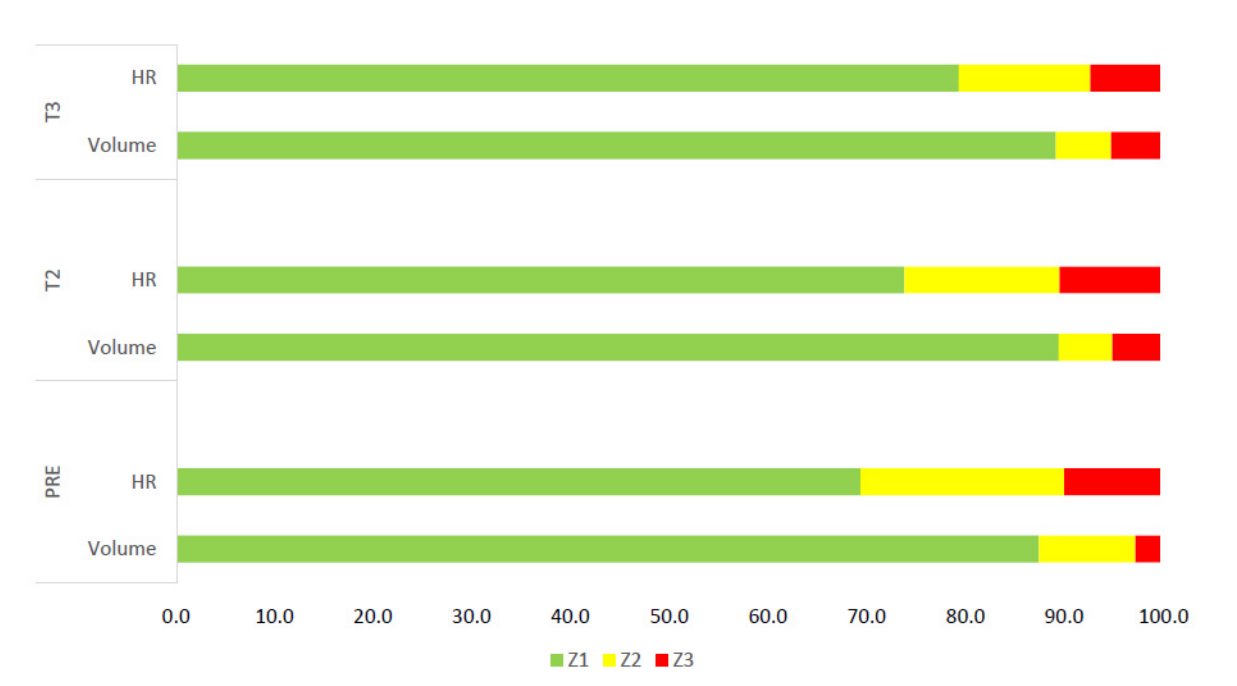
Figure 2. Training intensity distribution using training volume, expressed in km, and HR during PRE, T2, and T3. All values are expressed as % of training/time sessions. HR, heart rate .